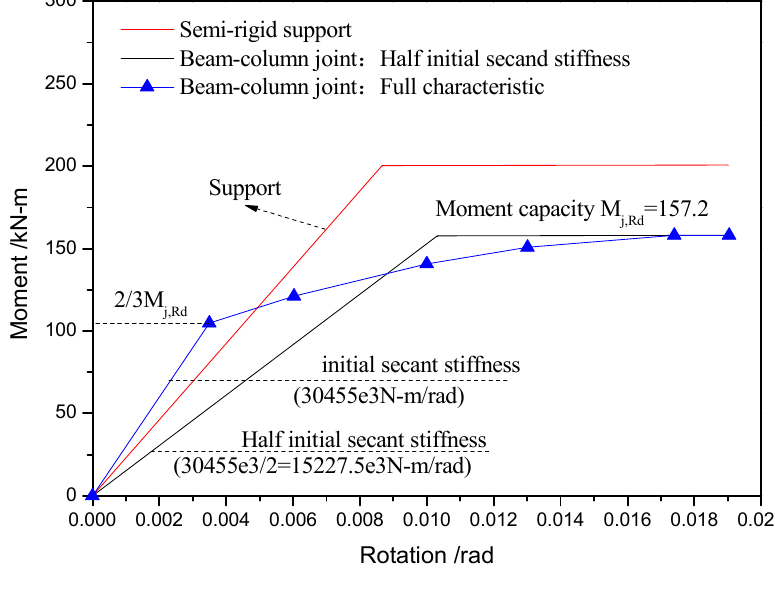
Figure 14. Load-moment curves.